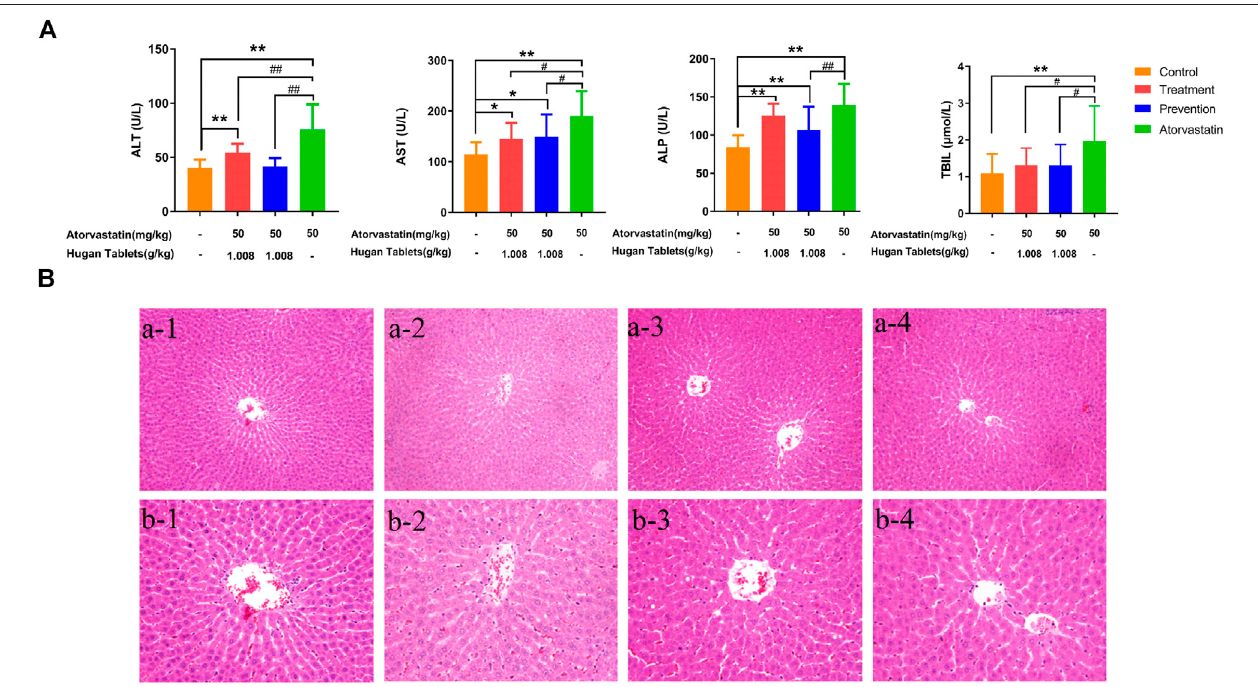
FIGURE 2 | Ef fi cacy of Hugan tablets in ameliorating DILI. (A) Effects of Hugan tablets on alleviating elevated serum ALT, AST, ALP, and TBIL, resulting from atorvastatin-induced liver injury (n Control (cid:2) 13; n Treatment (cid:2) 10; n Prevention (cid:2) 15; n Atorvastatin (cid:2) 12). Dataare presented asmean ± SD. * p < 0.05, ** p < 0.01 vs. control group, # p < 0.05, ## p < 0.01vs.atorvastatingroup. (B) Histomorphologyoflivertissuesofratsindifferentgroups(HE,a × 200,b × 400). 1:controlgroup;2:atorvastatingroup; 3: prevention group; 4: treatment